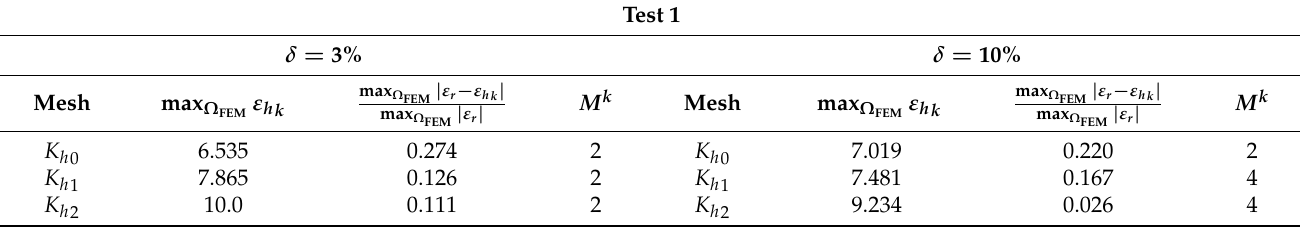
ε hk on a coarse and on Table 2. Test 1. Computational results of the reconstructions max Ω FEM adaptively refined meshes together with relative errors computed in the maximal contrast of ε r ,max Ω ε hk . Here, max Ω ε hk denotes the maximum of the computed function ε h on max Ω FEM FEM FEM k -times refined mesh K hk in the domain Ω FEM , and M k denotes the final number of iterations in the conjugate gradient Algorithm 3 on k -times refined mesh K hk for reconstructed function ε hk , k = 0,1,2. Test